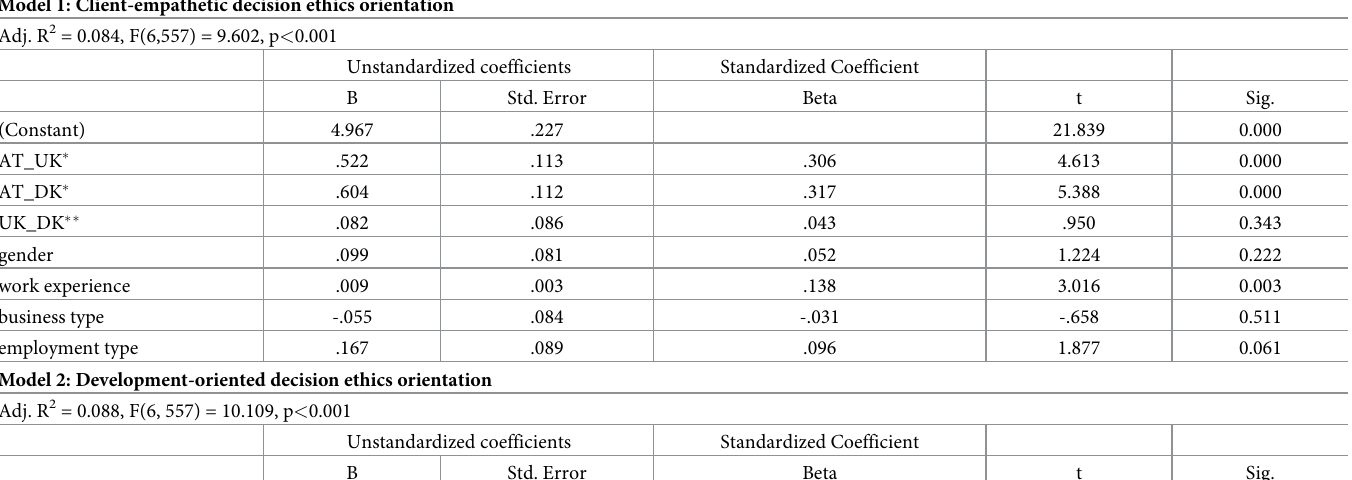
Model 2: Development-oriented decision ethics orientation